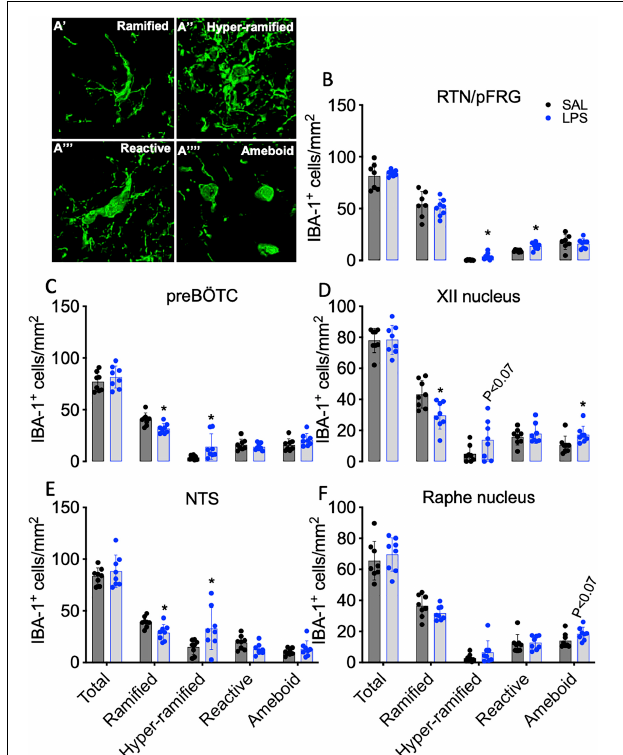
FIGURE 6 | GFAP + astrocytes within brainstem respiratory centers. Representative photomicrographs of GFAP + labeling (red) and the nuclear stain HOECHST (blue) in the RTN/pFRG of a control (A) and LPS exposed fetus (A’) . Scale = 20 µ m. Numbers of GFAP + astrocytes in the brainstem respiratory centers in SAL (control = black, n = 8) and LPS-exposed fetuses (blue, B , n = 8). Data are mean ± SD, * P < 0.05 vs. control, ** P < 0.01 vs. control.